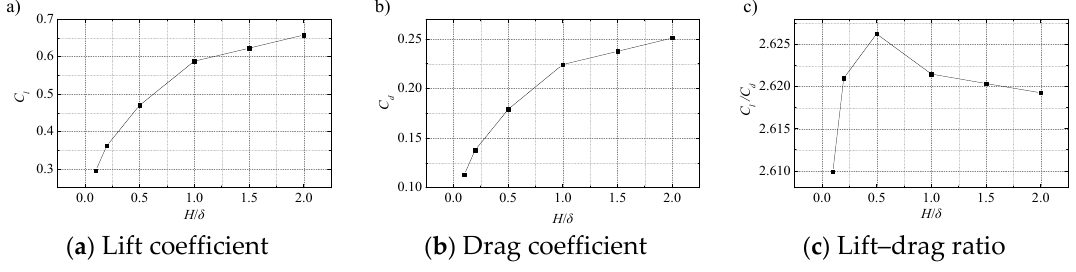
Figure 15. Lift and drag coefficient and lift–drag ratio with VG.